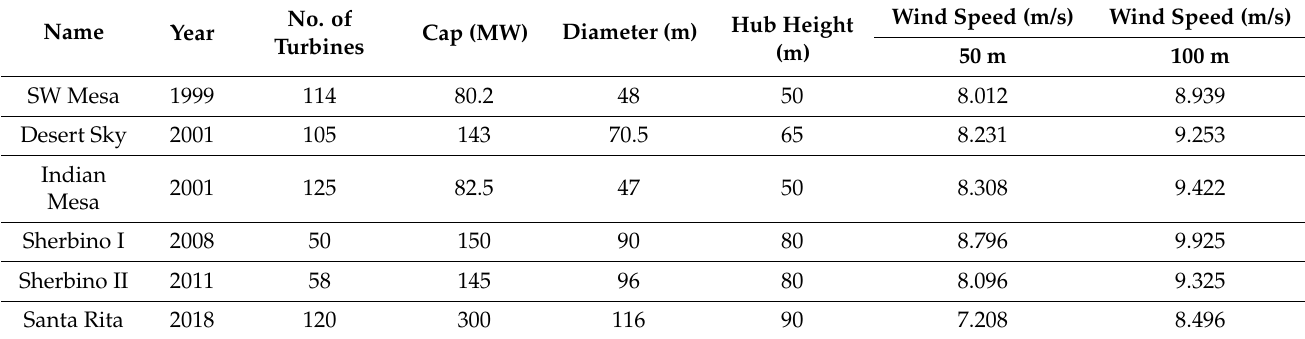
Table 1. Data from the evaluated cluster of six wind farms in central west Texas.